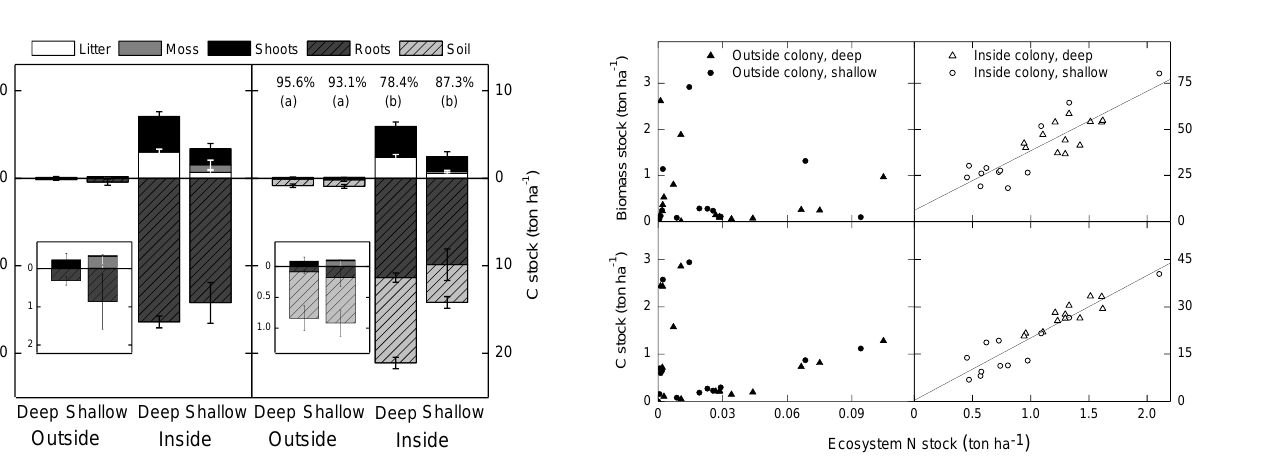
Figure 6. Relationships between ecosystem biomass stocks (up- per graphs) and ecosystem C stocks (bottom graphs) and ecosys- Fig. 6. Relationships between ecosystem biomass stocks (upper graphs) and ecosystem carbon 726 tem N stocks. Left graphs show the relationship outside the seag- stocks (bottom graphs) and ecosystem N stocks. Left graphs show the relationship outside the 727 ull colony, right graphs show the relationship inside the seagull colony. Note the difference in scale of the y axis between the left seagull colony, right graphs show the relationship and inside the seagull colony. Note the 728 and the right panel. Correlation function for biomass inside the difference in scale of the y-axis between the left and the right panel. Correlation function for 729 colony: biomass = 6 ( ± 4) + 32 ( ± 4) * ecosystem N stock ( r =0.86; t = 8.01; Df = 22; p <0.001). Correlation function for C inside biomass inside the colony: Biomass = 6 (± 4) + 32 (± 4) * ecosystem N stock (r = 0.86; t = 8.01; 730 the colony: C = 0.4 ( ± 1.9) + 19.8 ( ± 1.7) * ecosystem N stock Df = 22; p < 0.001). Correlation function for C inside the colony: C = 0.4 (± 1.9) + 19.8 (± 1.7) 731 ( r = 0.93; t = 11.75, Df = 22, p <0.001). Errors are SEs. * ecosystem N stock (r = 0.93; t = 11.75, Df = 22, p < 0.001). Errors = SE’s. 732 perature and volumetric water content were 7.5 ◦ C and